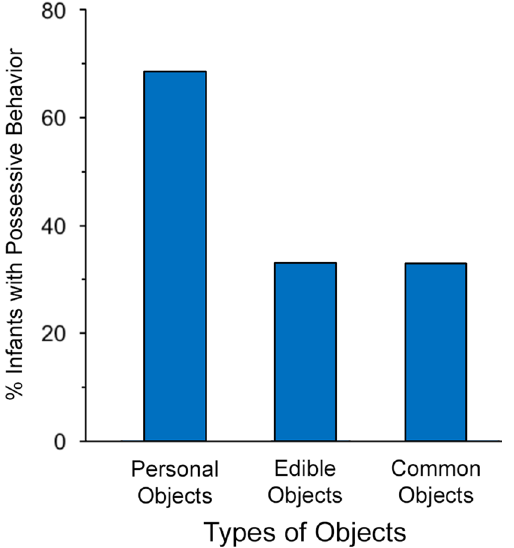
Figure 2. Percent of infants exhibiting possessive behavior as a function of object type in Experiment 2. More infants displayed possessive behavior (dichotomous yes/no) toward their own personal objects than to edible objects or common objects (see text for statistical details).